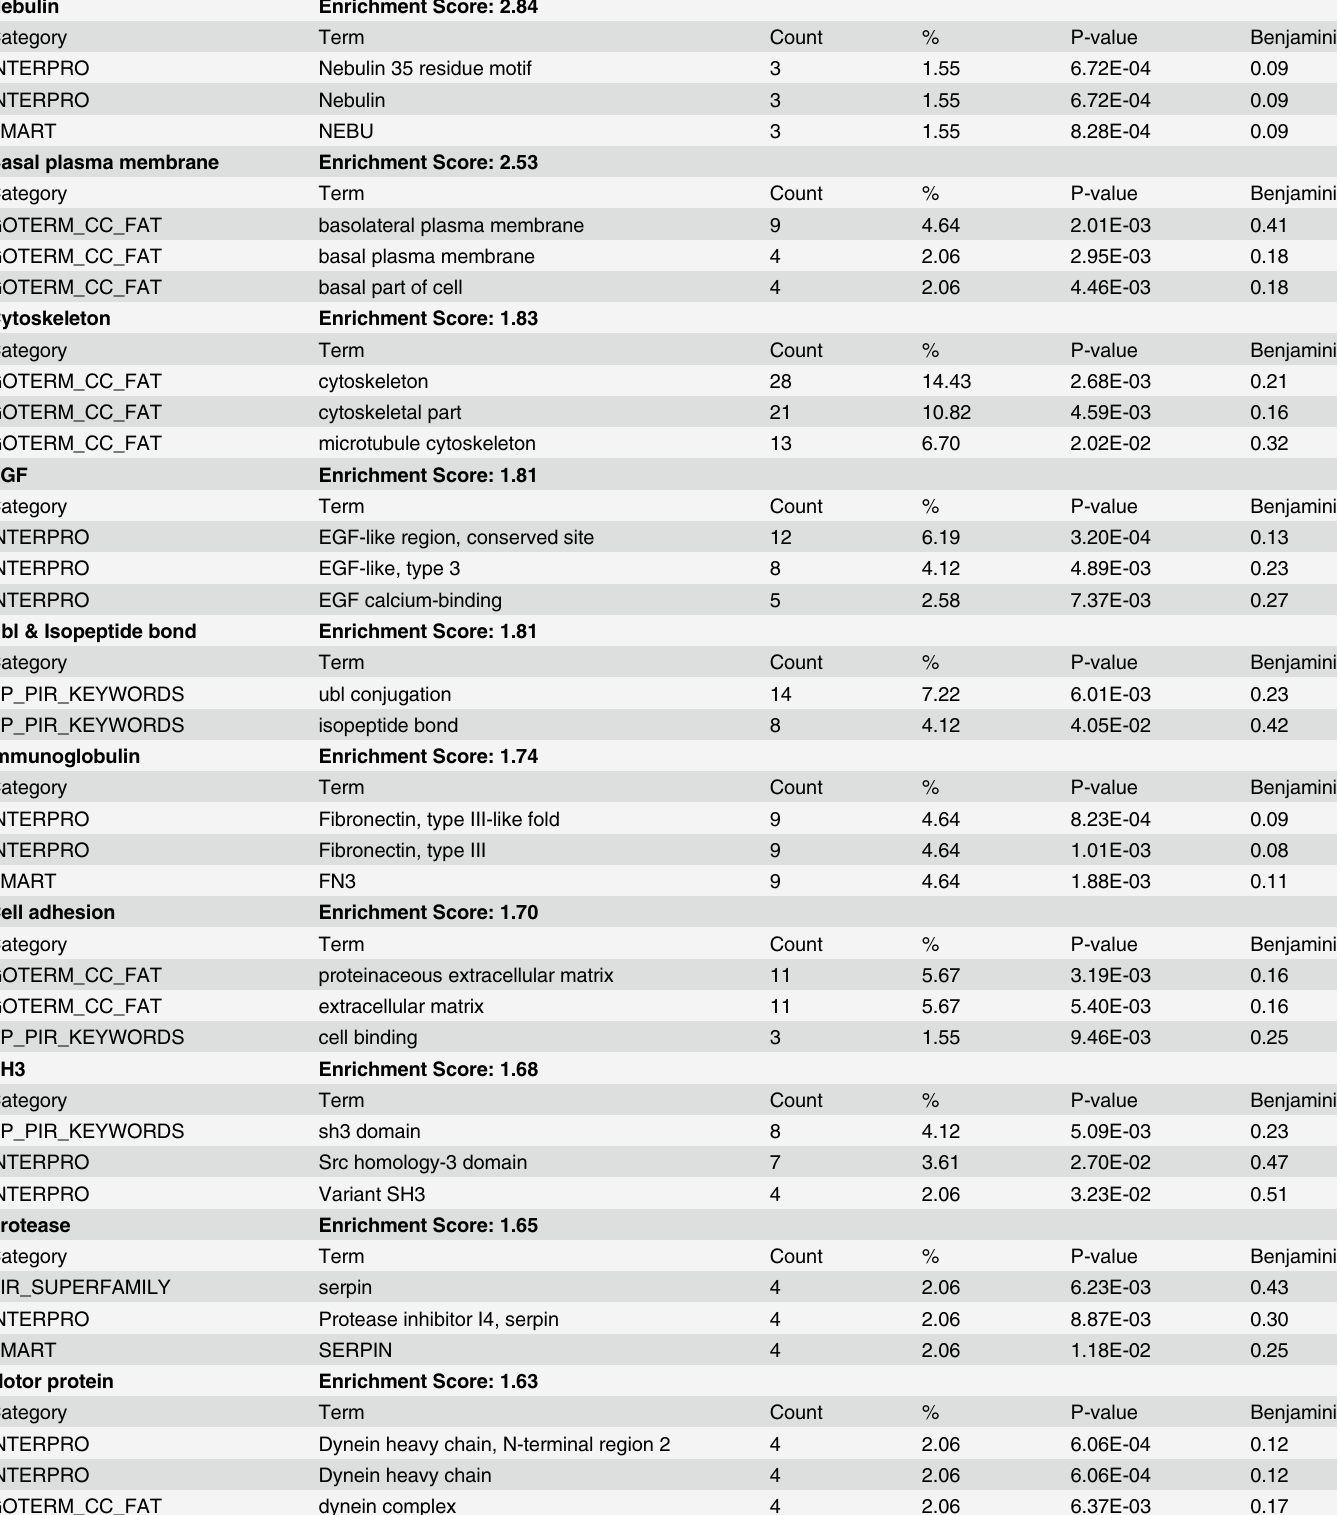
Table 1. Top 10 clusters ranked by enrichment score and representative terms in each cluster from GSEA results (based on DAVID). Nebulin Enrichment Score: